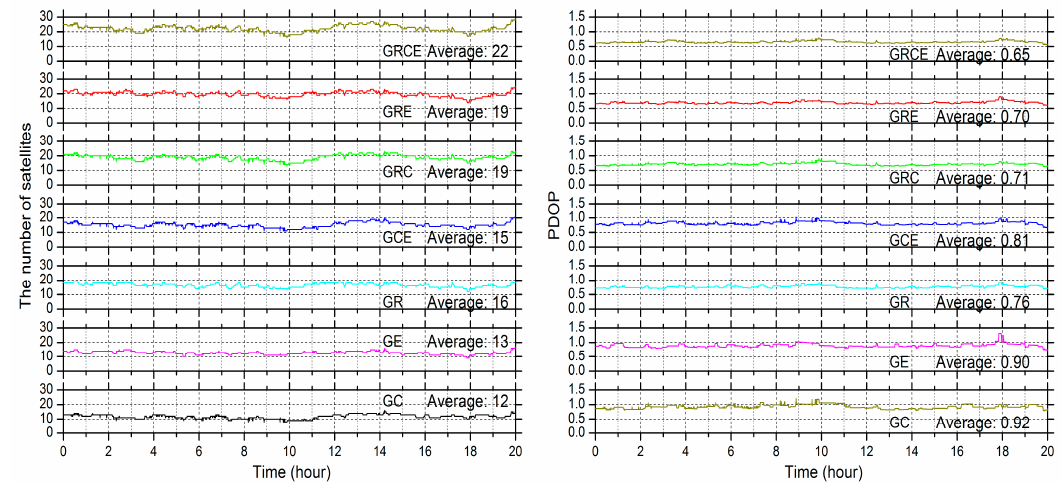
Figure 8. The number of visible satellites ( left ) and the position dilution of precision (PDOP) value ( right ) for each combination scheme at the station BRST.